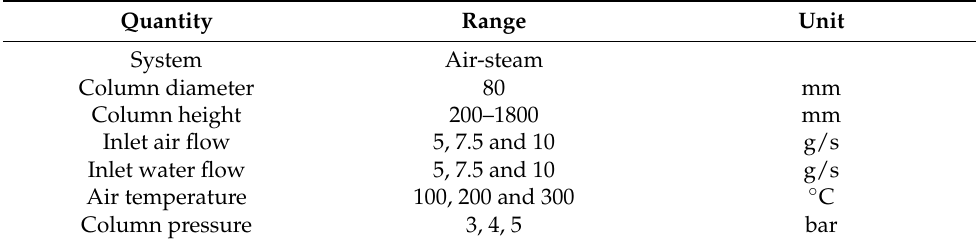
Table 3. Experimental conditions in [36–39].